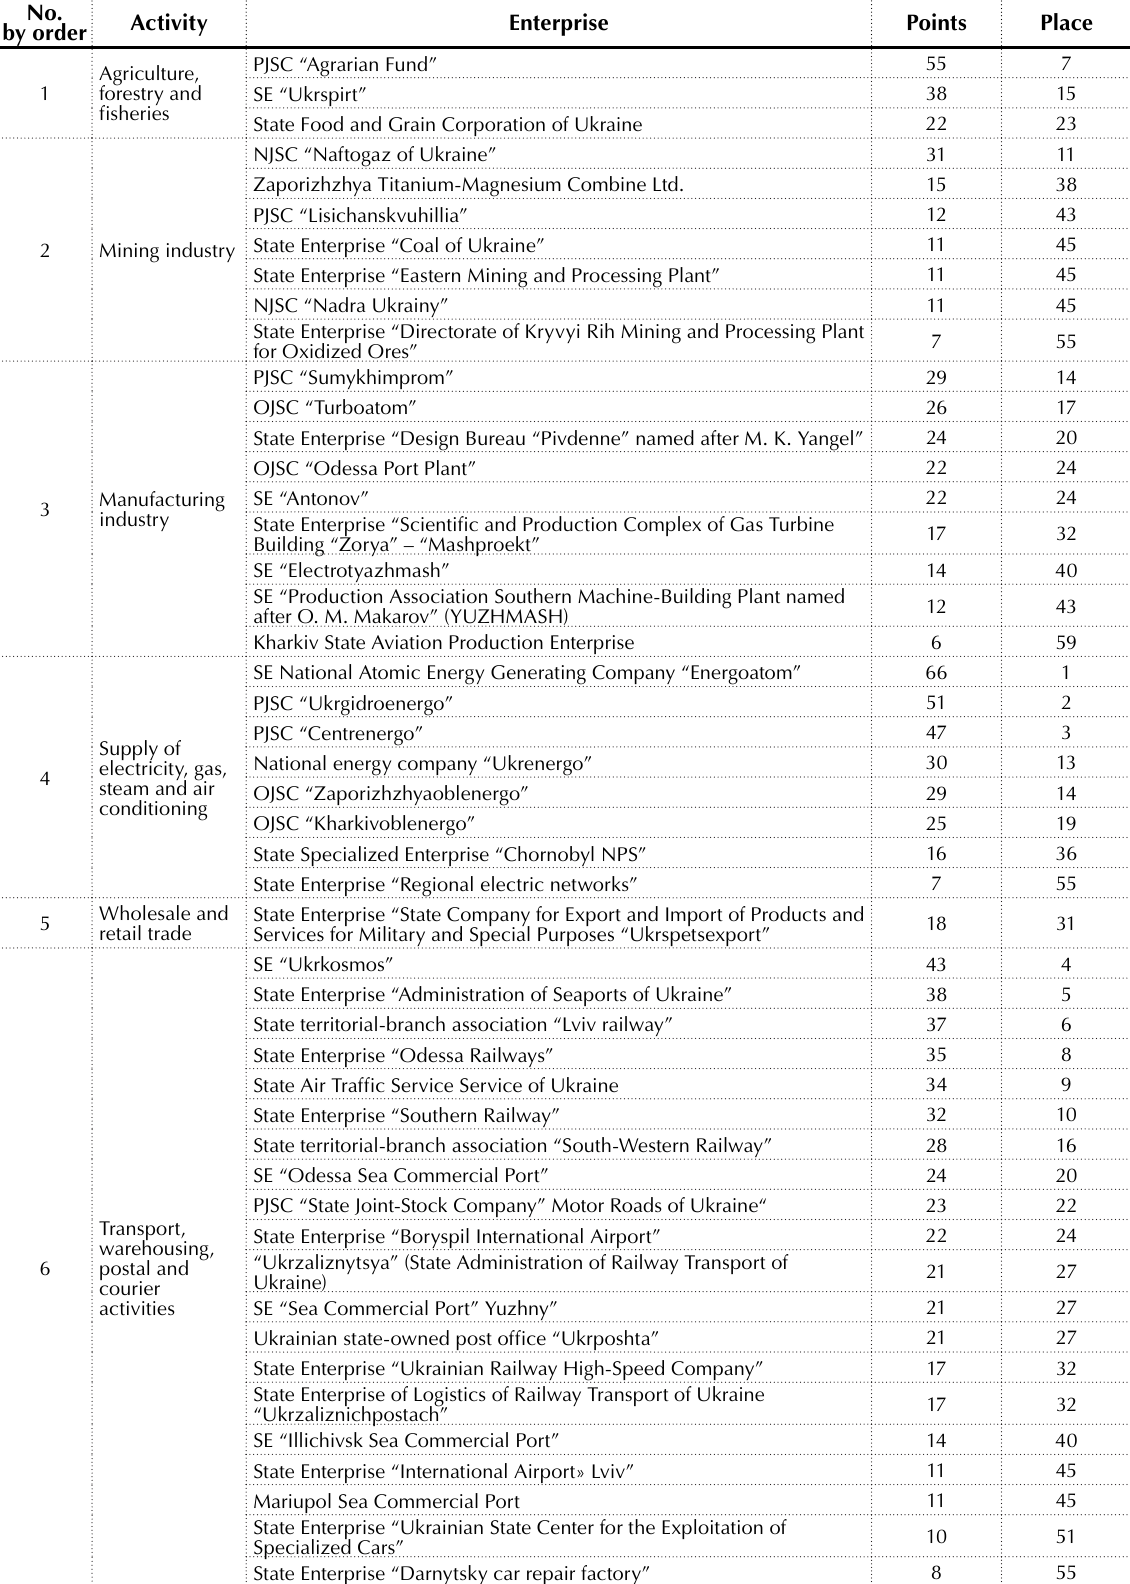
Table 1. Index of transparency of Ukrainian state-owned companies by their sectoral affiliation Source: Created by the authors according to Center for Corporate Social Responsibility